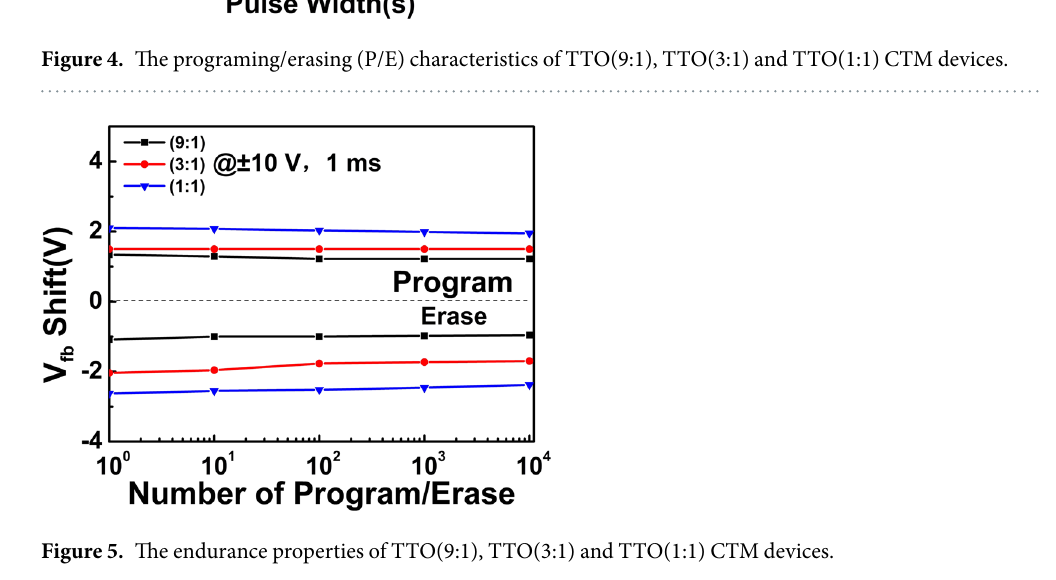
programed into or erased from the charge trapping layer. There exists obvious Δ V FB in the C-V curves of all devices at an applied voltage with a pulse width of 10 − 6 s, and TTO(1:1) CTM device gets the largest Δ V FB of 0.91 V, much larger than that obtained in TiO 2 -Al 2 O 3 CTM device as well as Si 3 N 4 , Ta 2 O 5 , HfO 2 and ZrO 2 CTM devices 18, 31–33 . With the increase of the pulse width of the applied voltage, the values of Δ V FB increase quickly in all devices, and Δ V FB in TTO(1:1) CTM device at the applied voltage with a pulse width of 0.1 s is about 7.49 V. The differences among the P/E speeds of three TTO CTM devices should be attributed to their special band alignments as shown in Fig. 3c and individual density of trapped charges. The heights of the potential barriers between p-Si and the charge-trapping dielectric for three TTO CTM devices can be roughly determined by com- paring the bottoms of conduction band (or Fermi level) between p-Si and TTO dielectrics. From Fig. 3c, there clearly exists the lowest height of the barrier between TTO(1:1) and p-Si. At a large enough positive voltage applied between the top and bottom electrodes, part of the voltage is employed for electrons to overcome the barrier between p-Si and TTO composite dielectric. The left part of the applied voltage provides electrons with dynamic energy to tunnel from p-Si through tunneling layer Al 2 O 3 to TTO charge-trapping layer, and then trapped in defect states. The electrons with a larger dynamic energy should have a larger probability to tunnel through the tunneling layer Al 2 O 3 . It was calculated that the injection current density of electrons in the program- ming process for a floating-gate memory device is proportional to the trapping density and the function 25, 26 . In TTO CTM devices the similar physical process should be − ∅ exp( ) q 1 , where Φ 1 is the barrier height KT expected. TTO(1:1) composite with the largest trapping density and the lowest barrier height among three TTO composites enables TTO(1:1) CTM device to get the largest injection current density at the same applied gate voltage, resulting in the largest Δ V FB as shown in Fig. 4. In contrast, TTO(9:1) CTM device gets the lowest Δ V FB , in which TTO(9:1) has the lowest trapping density and the largest barrier height. In the erasing process (discharg- ing), TTO(1:1) CTM device will also get the largest inverse current density due to the lowest barrier height and the largest amount of trapped charges in TTO(1:1) dielectric, thus resulting in the largest Δ V FB . properties of TTO(9:1), TTO(3:1) and TTO(1:1) CTM devices were investigated under a sweeping gate voltage with an amplitude of ± 10 V and a pulse width of 1 ms, as shown in Fig. 6. In order to get the tendency of data retention after ten years, the curves of three TTO CTM devices were extended to 3 × 10 8 s. The TTO(1:1) CTM